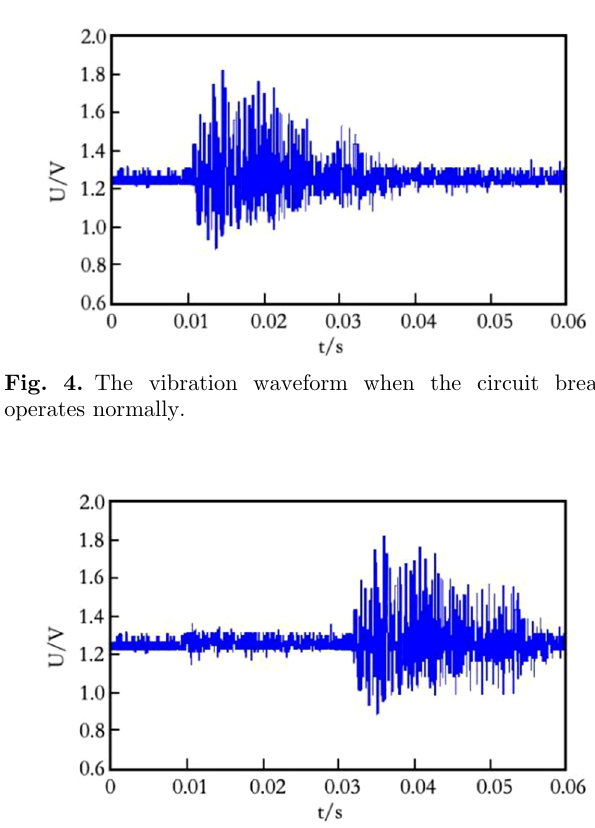
Fig. 5. The vibration waveform when the fi xed screw